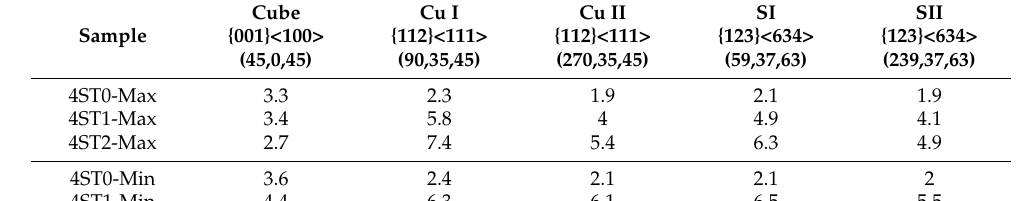
Figure 12. ODF section φ 2 = 45° of tube 4ST after different passes. Table 4. Cube, copper and S components for tube 4 (all units in mrd).